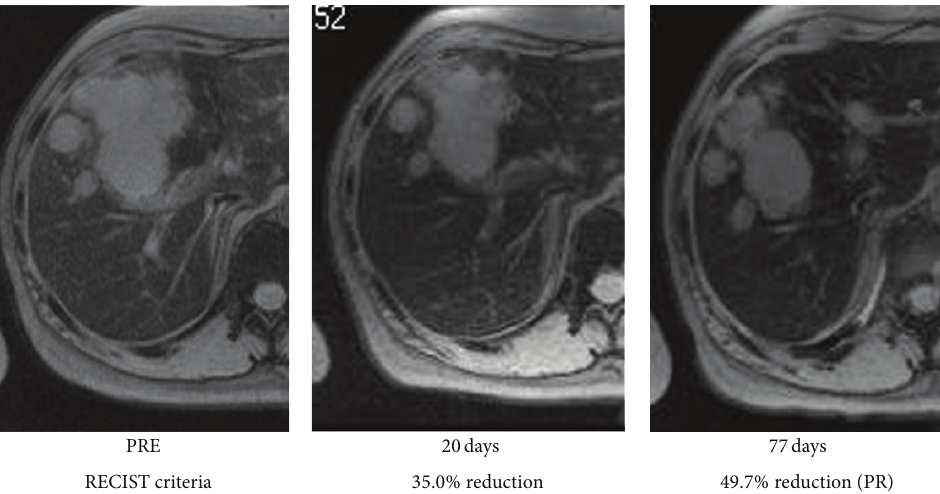
Figure 1: Evaluation of the size of liver metastases after chemotherapy by RECIST criteria. After 3 cycles of IRIS (77 days), the reduction in size of the tumor achieved 49.7%, which was interpreted as partial